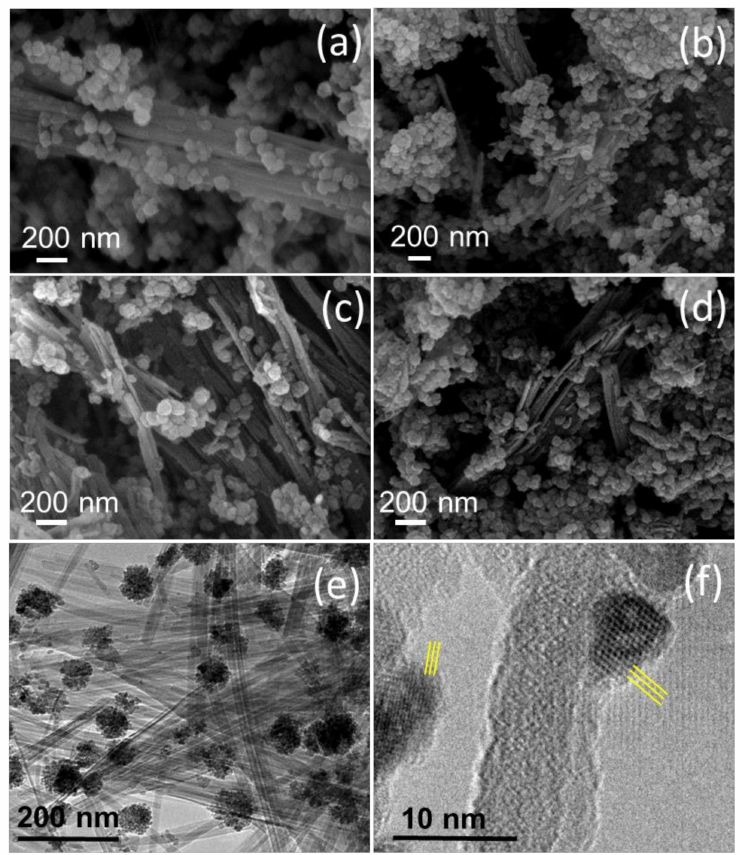
Figure 7. SEM images for ( a ) FO-Sep@C; ( b ) FO-Ben@C; ( c ) FO-Sep@C-400; and ( d ) FO-Ben@C-400; ( e , f ) HRTEM images for FO-Sep@C at different magnifications. Yellow lines indicate interplanar